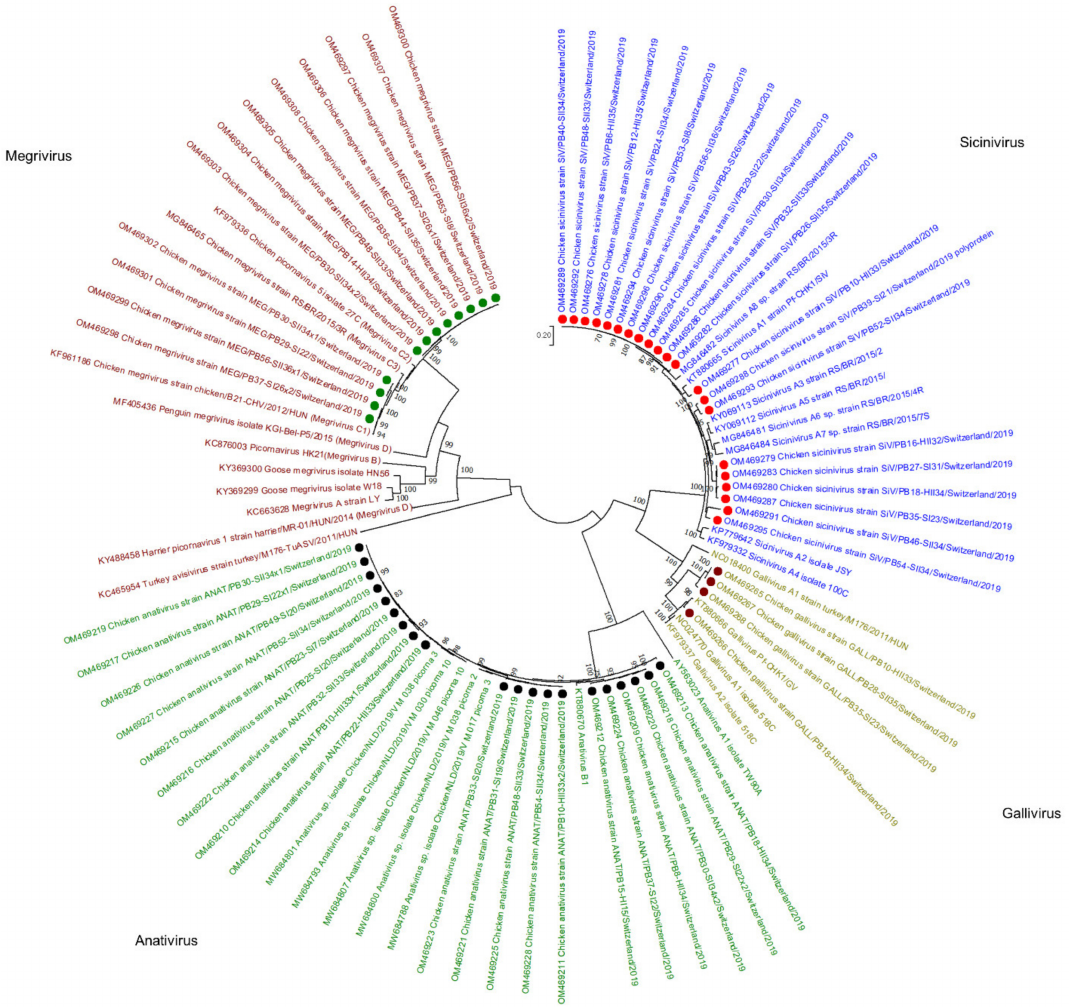
Figure 4. Phylogenetic tree based on the amino acid sequence identity of the polyproteins of selected picornaviruses. In red, green, olive, and blue, Megrivirus , Anativirus , Gallivirus , and Sicinivirus genera are presented, respectively. Contigs constructed in this study are marked by green ( Megrivirus ), black ( Anativirus ), purple ( Gallivirus ), and red ( Sicinivirus ) dots. Phylogenetic analysis was performed using the maximum likelihood algorithm based on the Tamura–Nei model with the 1000 replication bootstrap method. Only values ≥ 70% were displayed. Evolutionary analyses were conducted using MEGA